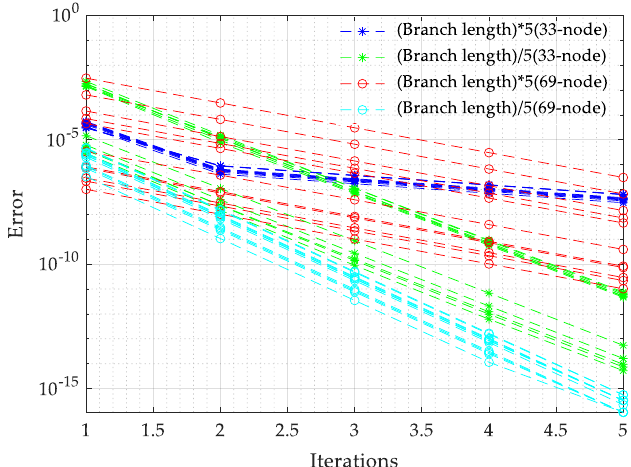
Figure 16. Convergence for different branch lengths from random initial points.